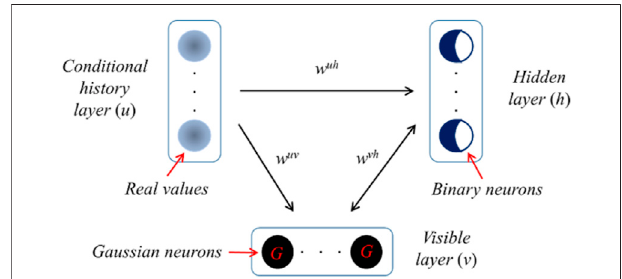
FIGURE 2 | Restricted Boltzmann Machine